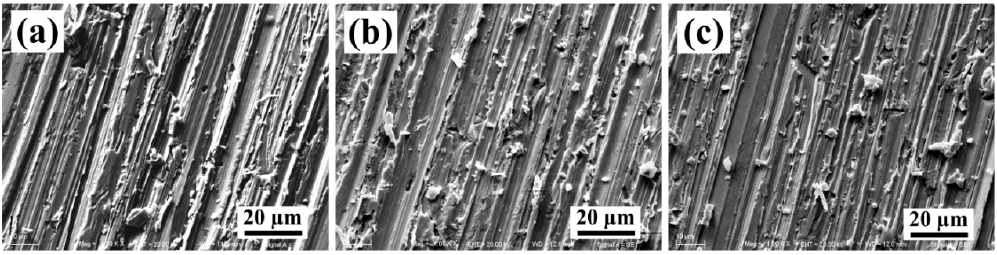
Figure 7. The morphologies of the worn surfaces for ( a ) Cu–Cr–Zr alloys, ( b ) 2-wt % and ( c ) 4-wt % nano-sized TiCp-reinforced Cu–Cr–Zr comp osites at 13 μ m abrasive particles.